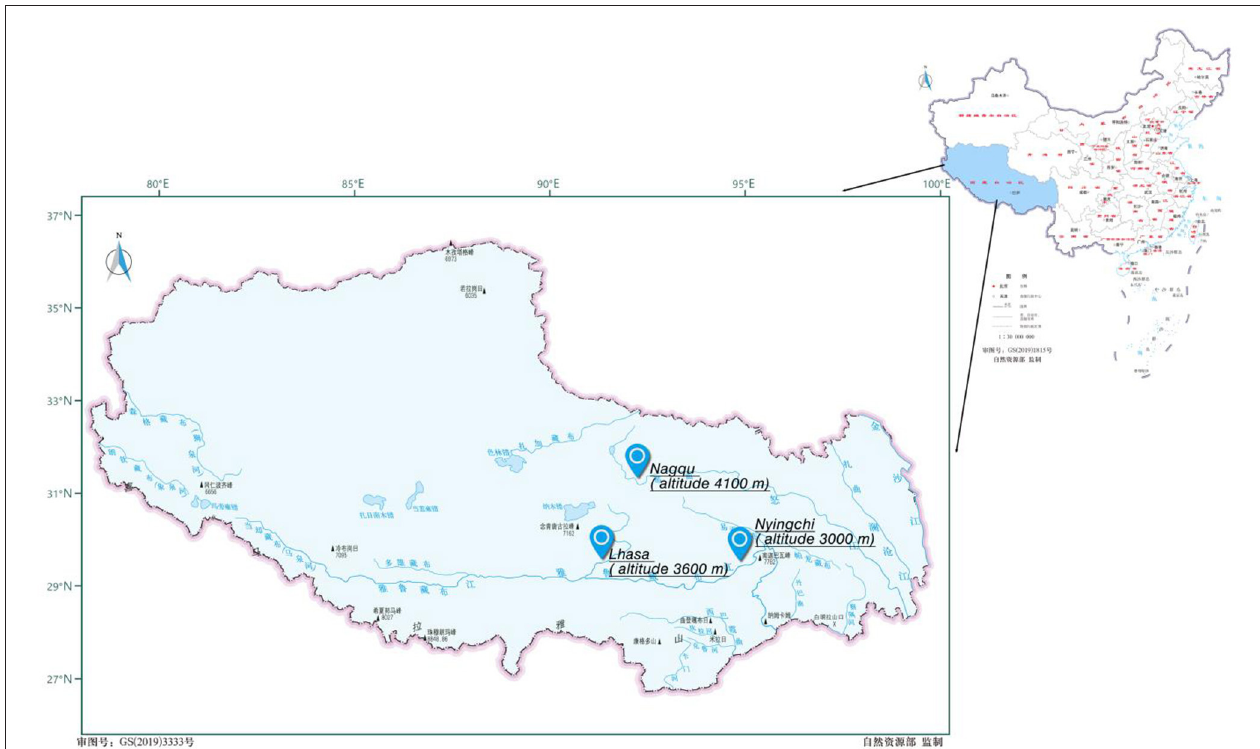
FIGURE 1 | Map of the three cities in Tibet of